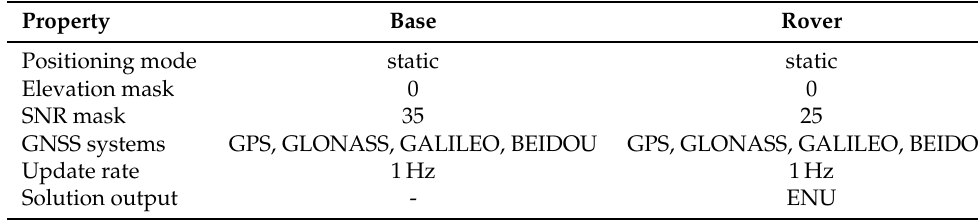
Table A1. RTK GNSS refractometry observation settings.